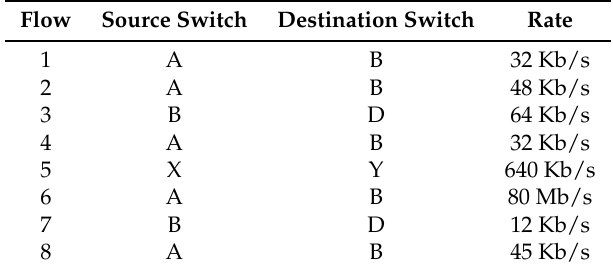
Table 2. Sample flow specification.